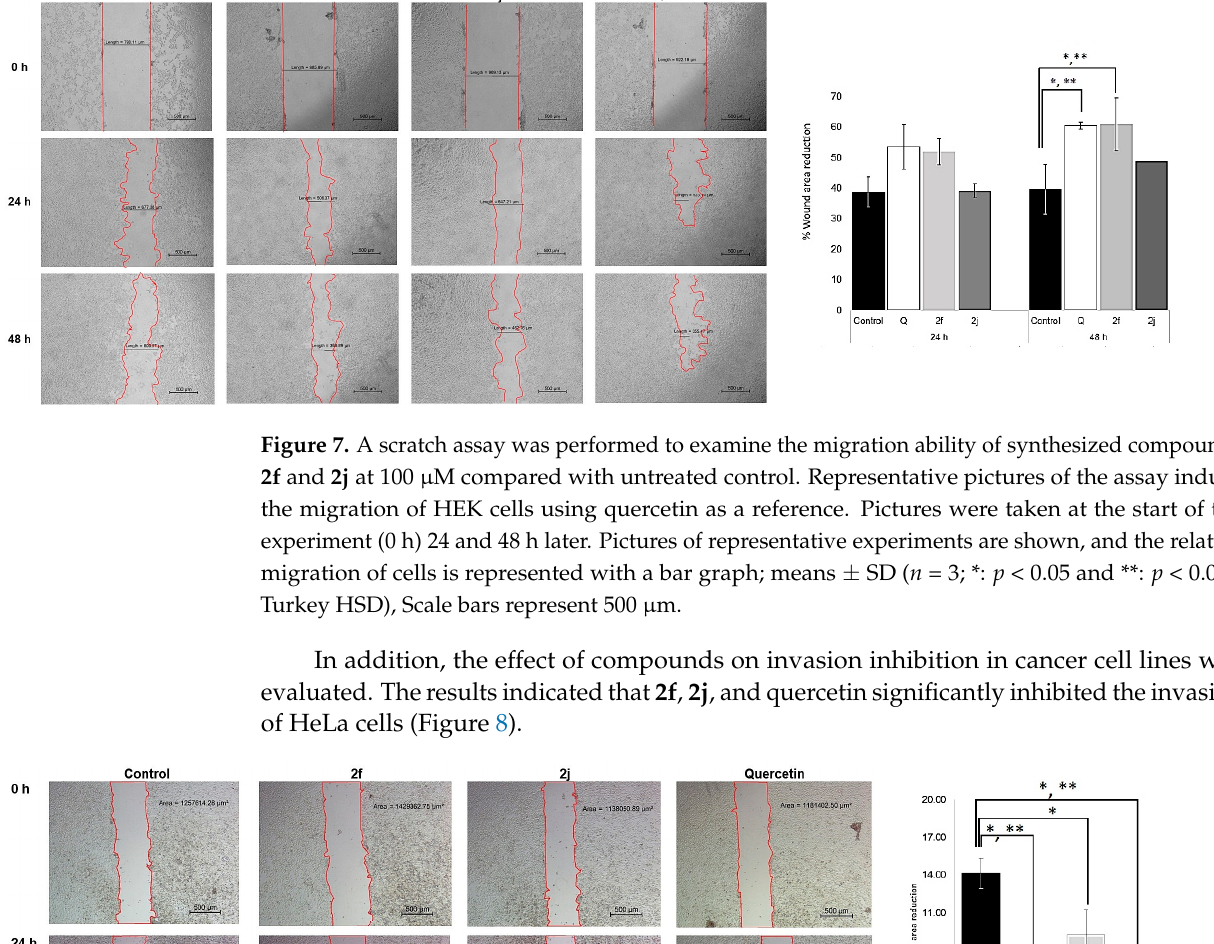
Table 4. Percentage of population in each cell cycle phase after treatment with quercetin, 2f , and 2j in HeLa cells.